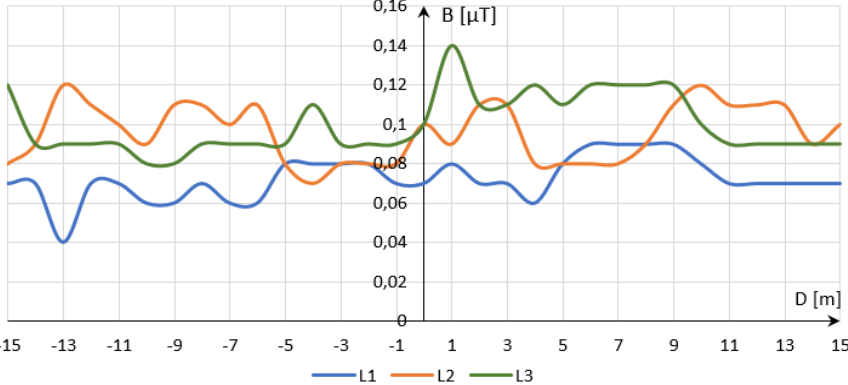
Figure 7. Distribution of magnetic field induction B along L1, L2, L3 phase conductors of the 30 kV power line No. 1, ELF frequency range.